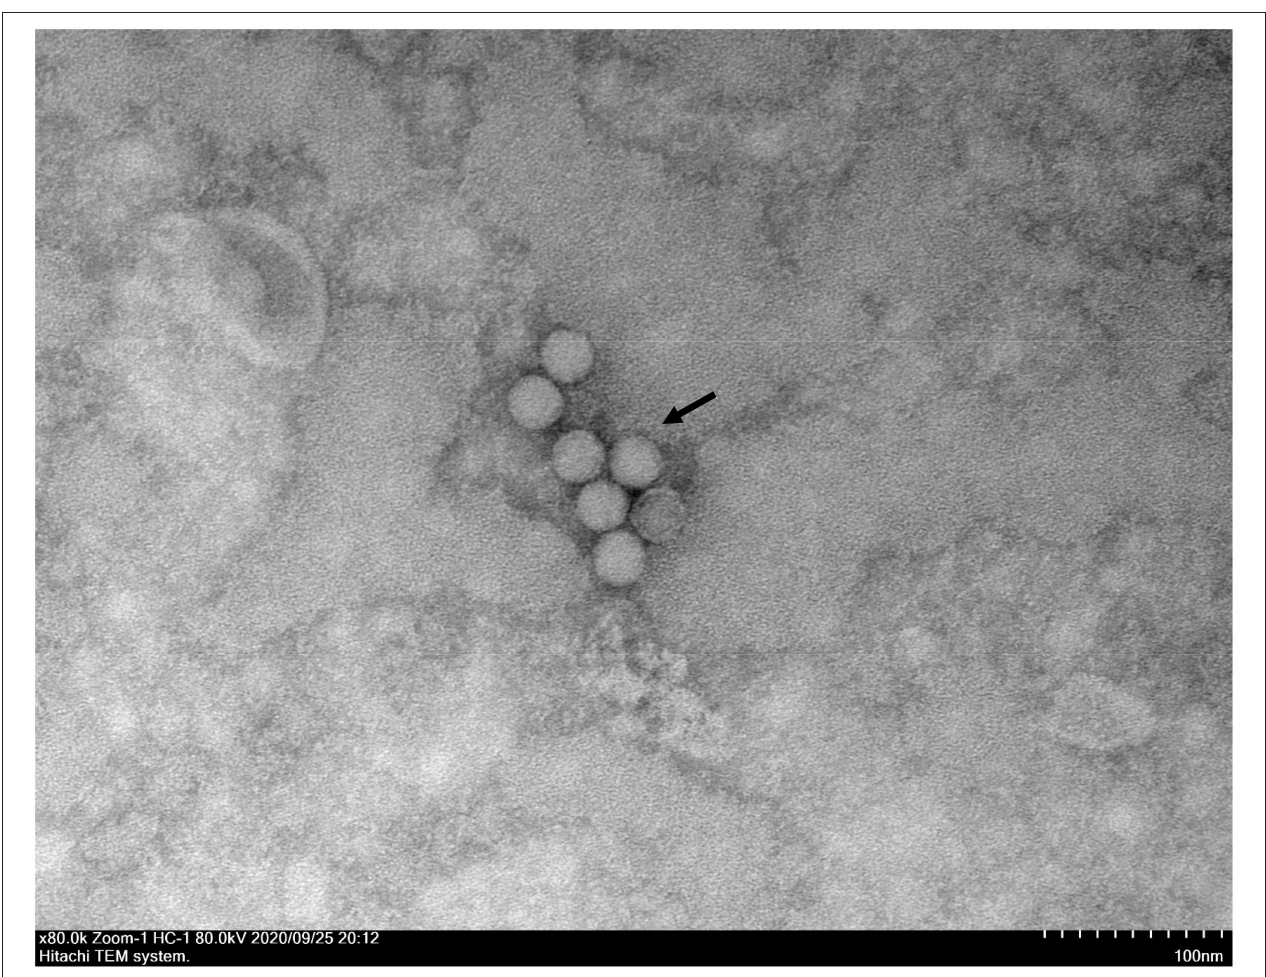
FIGURE 3 | A transmission electron microscopic image of purified EV-G particles. Spherical virions with a diameter of 25–30nm were observed and marked with a black arrow. The sample was negatively stained with 2% phosphotungstic acid. Scale bar indicates 100nm